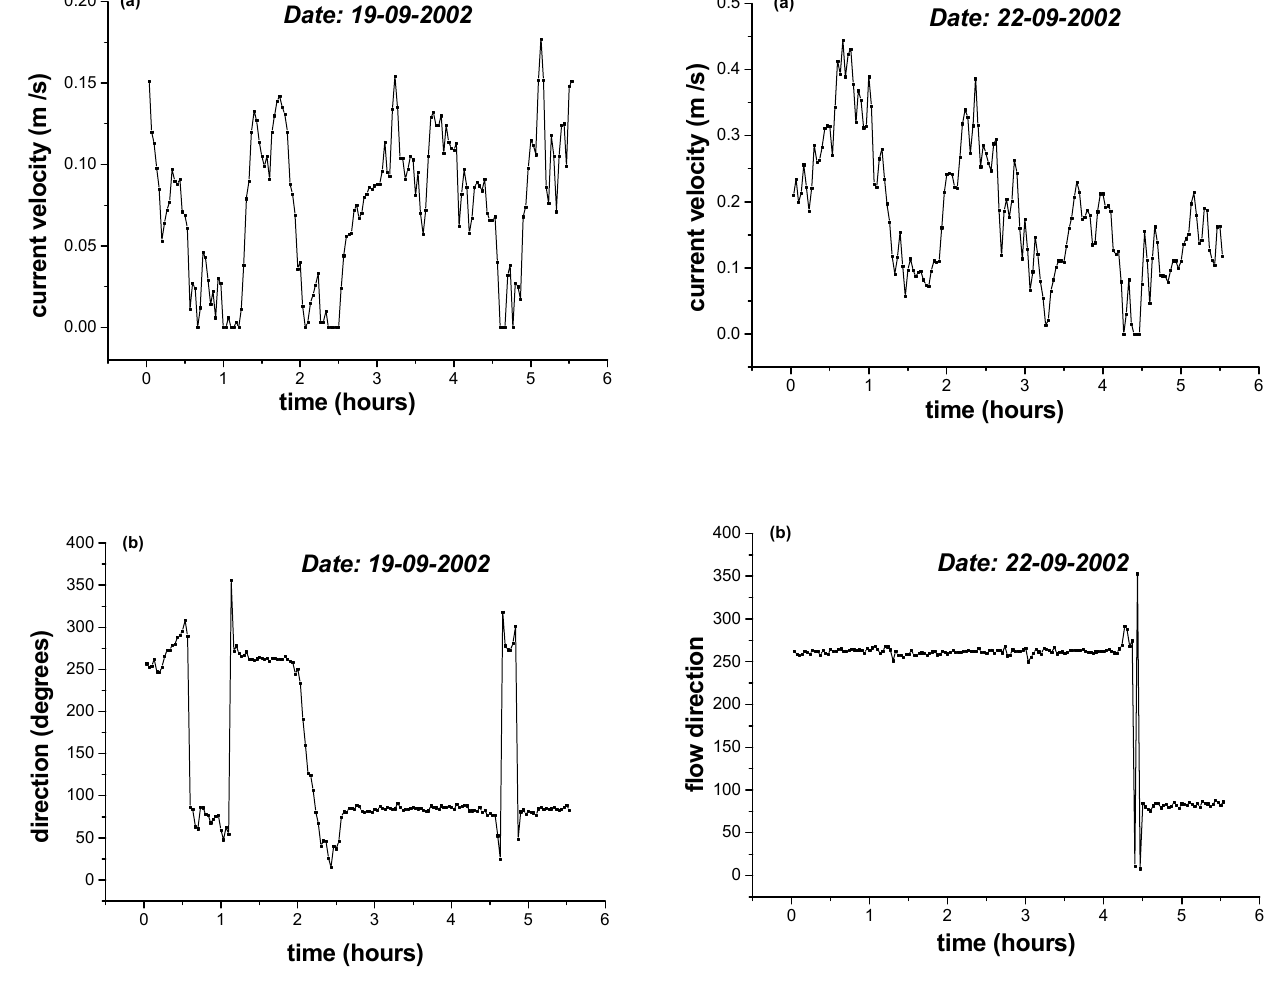
Fig. 4. (a) Current velocity versus time (19 September 2002), (b) Current direction versus time (19 September 2002).